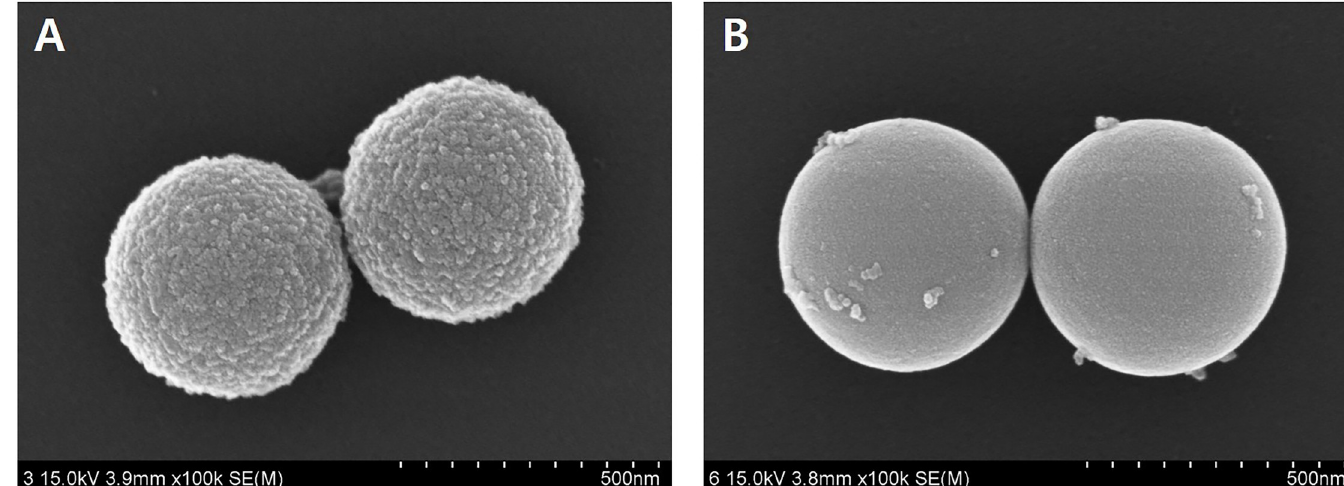
Fig 6. FESEM images of (a) MBGN and (b) Dense BGN.